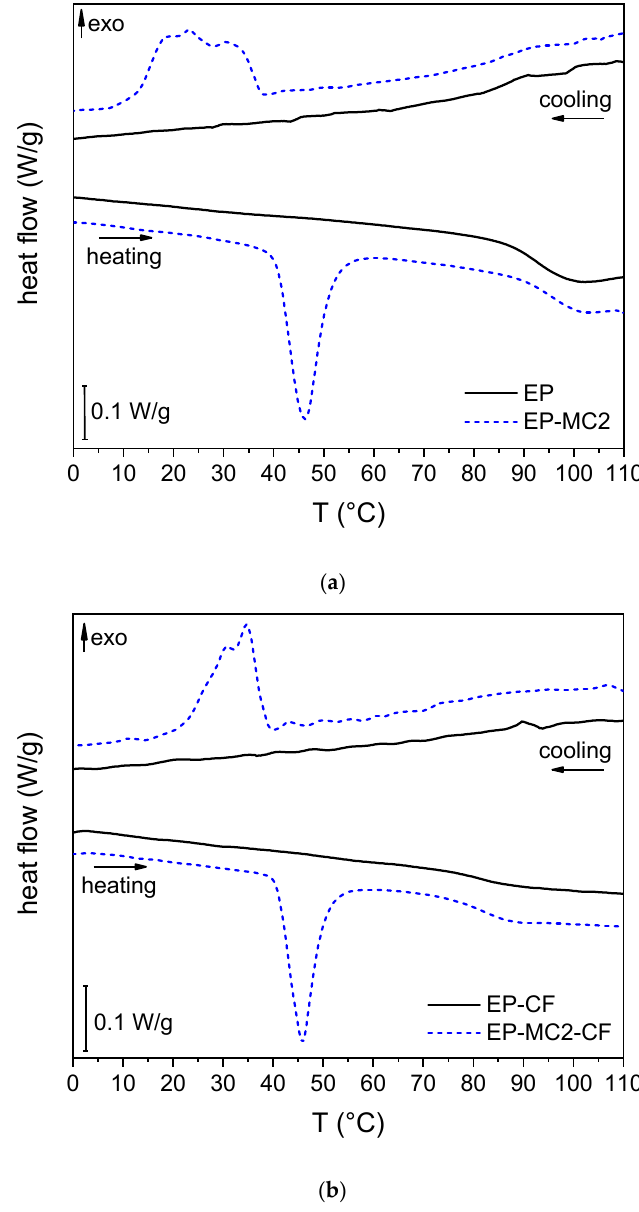
Figure 9. DSC thermograms of the prepared epoxy-based matrices and laminates. The first heating scans and the cooling scans are reported. ( a ) EP and EP-MC2; ( b ) EP-CF and EP-MC2-CF.